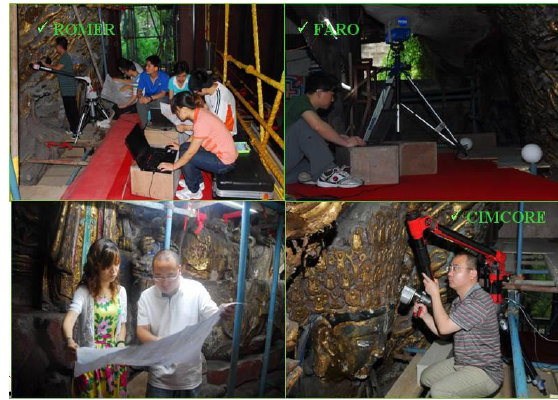
Figure 2. Data Acquisition Using CimCore